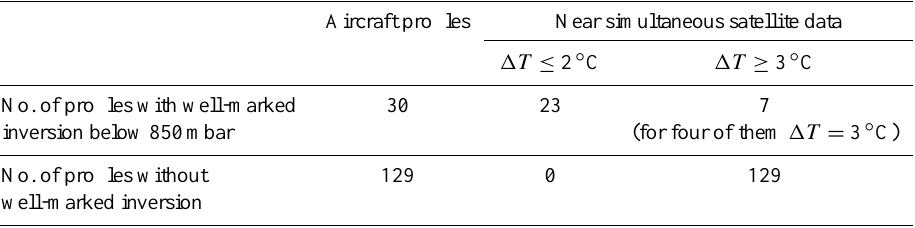
Table 2. Comparison of aircraft profiles with satellite